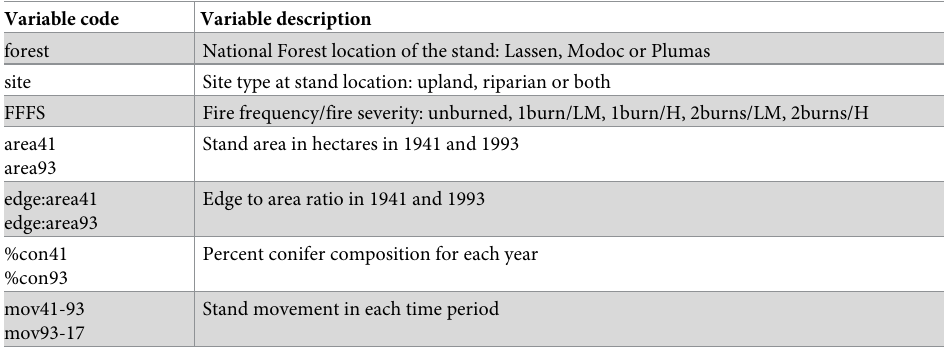
Table 2. List of candidate explanatory variables for analysis of changes in aspen-conifer